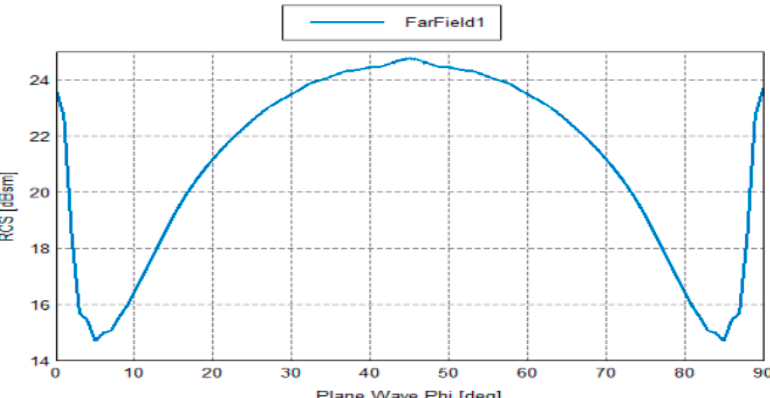
Figure 2. Radar cross-section distribution characteristics of the corner reflector when the pitch angle is 55°.